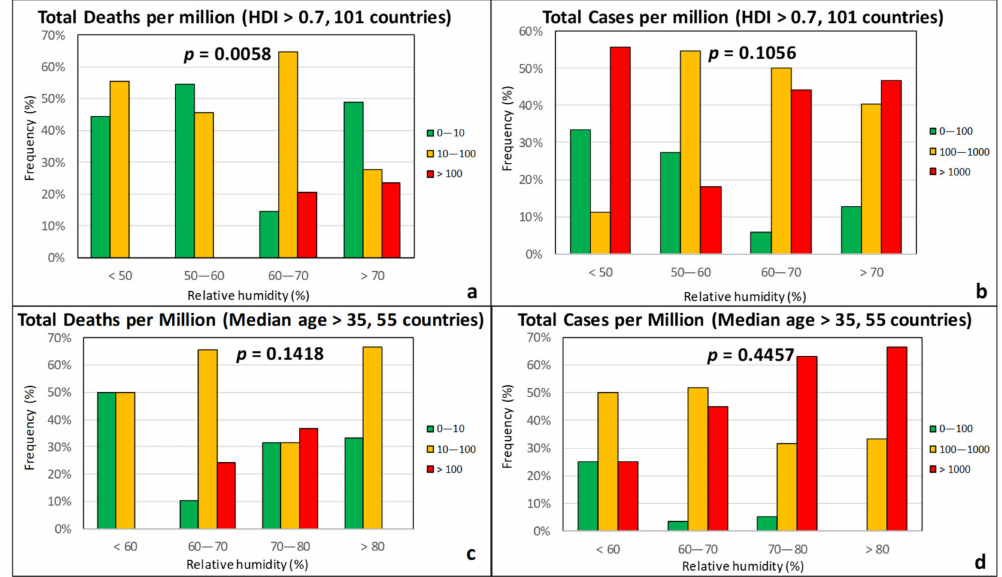
Figure 5. Frequency of total deaths per million (green: low, 0–10; orange: moderate, 10–100; red: high, > 100) and total cases per million (green: low, 0–100; orange: moderate, 100–1000; red: high, > 1000) as a function of the relative humidity for countries with an HDI over 0.7 ( a , b ) and a median age over 35 years ( c , d